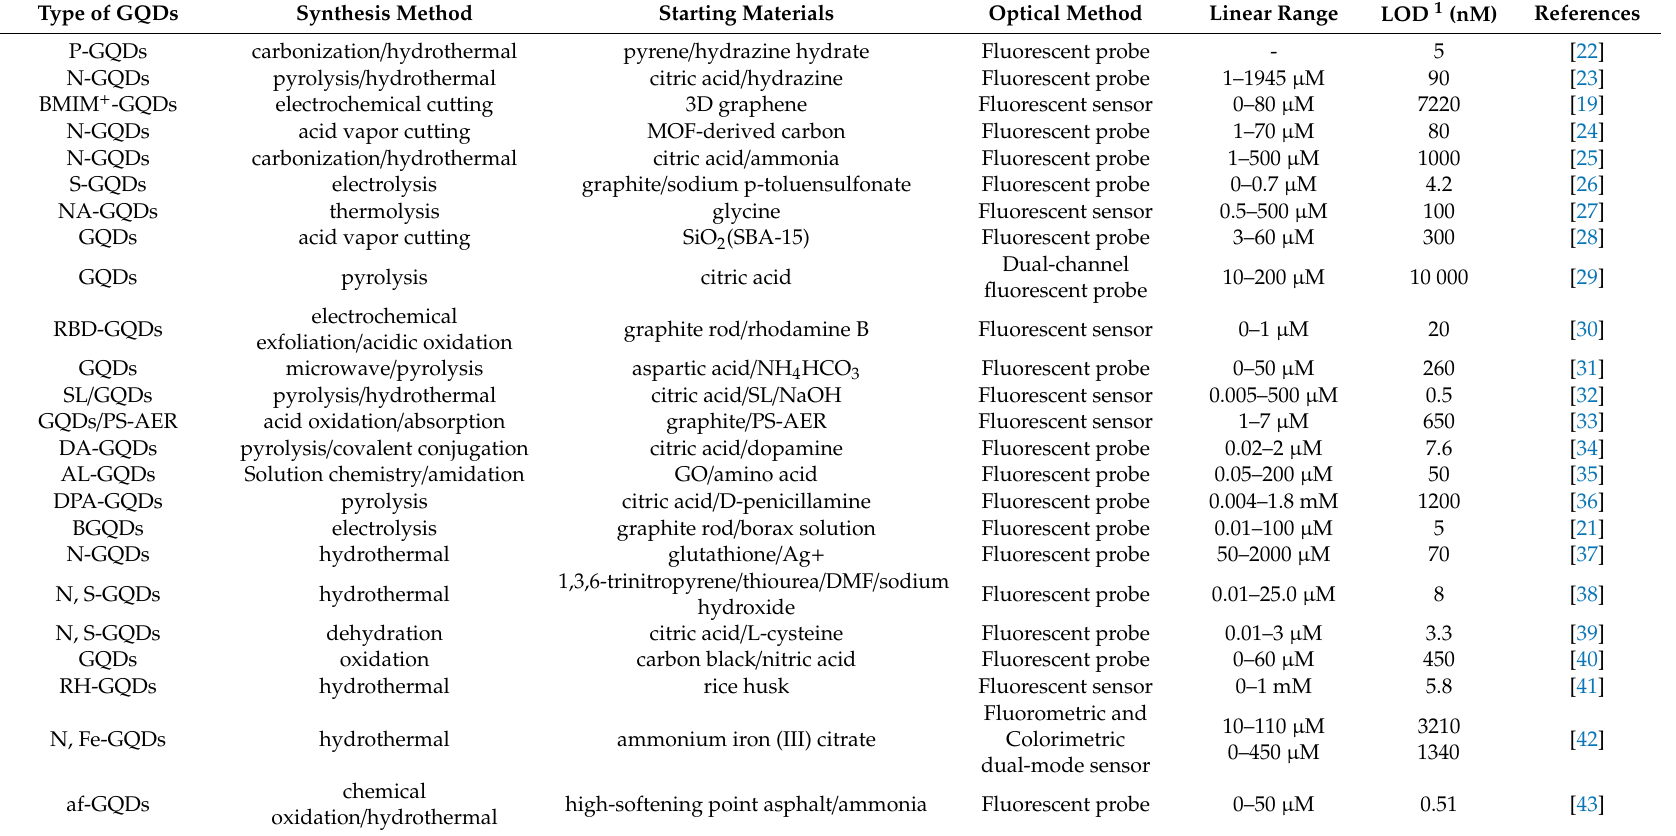
Table 2. The GQDs-based optical sensor for ferric ion